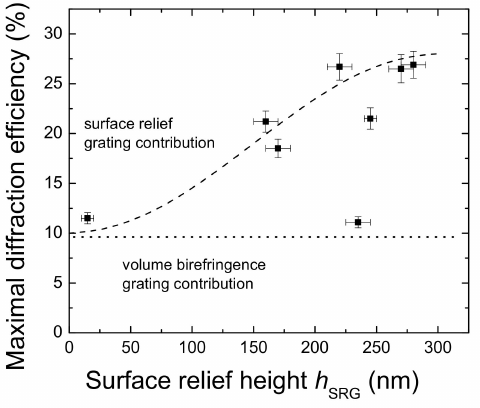
Figure 8. Dependence of the diffraction efficiency in the +1 order (DE +1 max ) on the height of the surface relief ( h SRG ). The dashed line illustrates the contribution of the surface relief grating to the diffraction